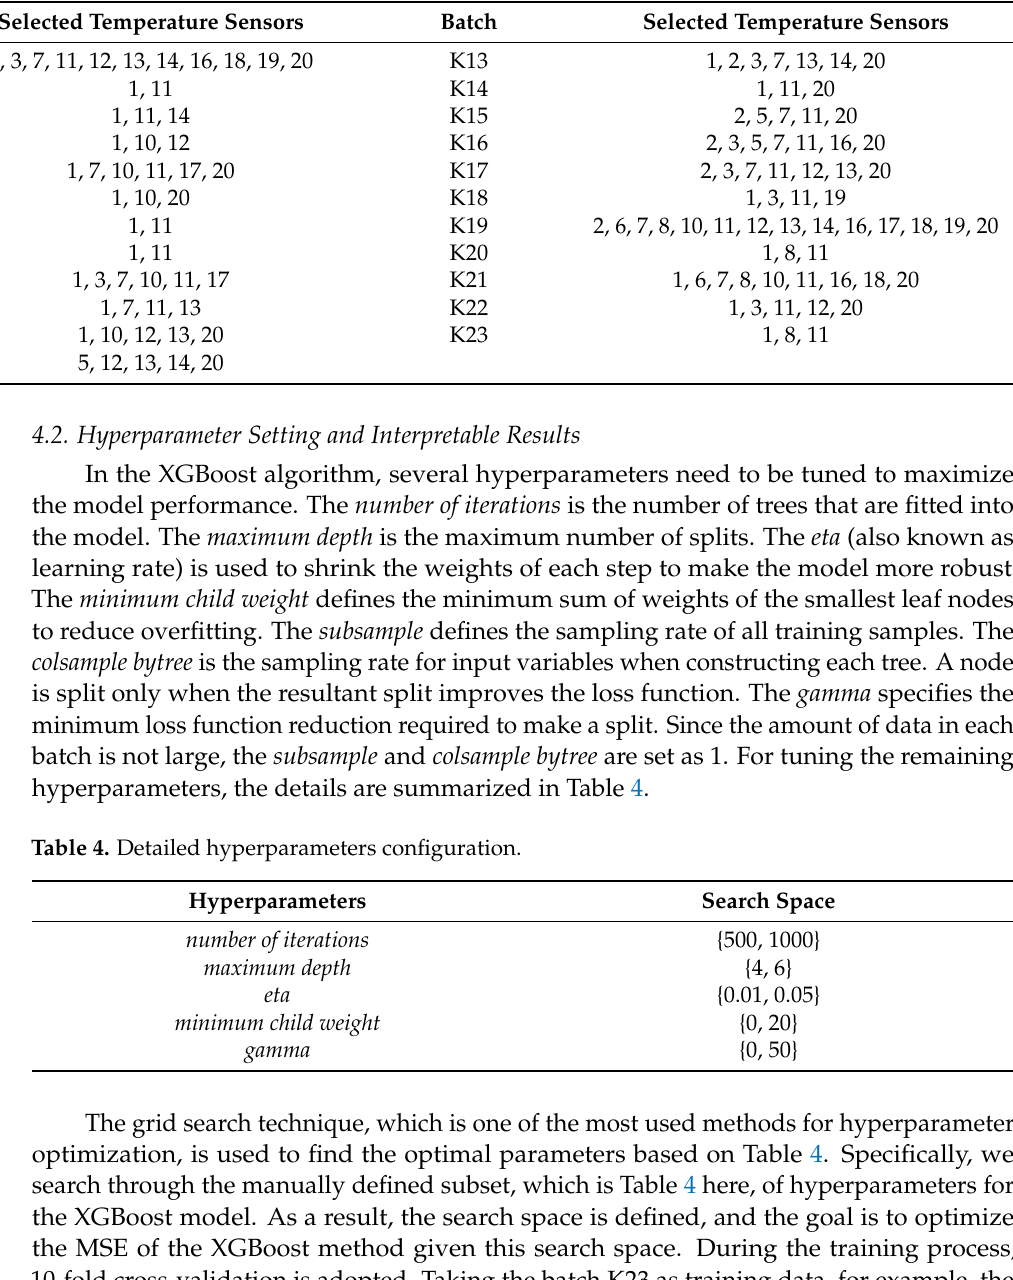
Table 3. Selected temperature-sensitive variables for each batch by the adaptive LASSO method.